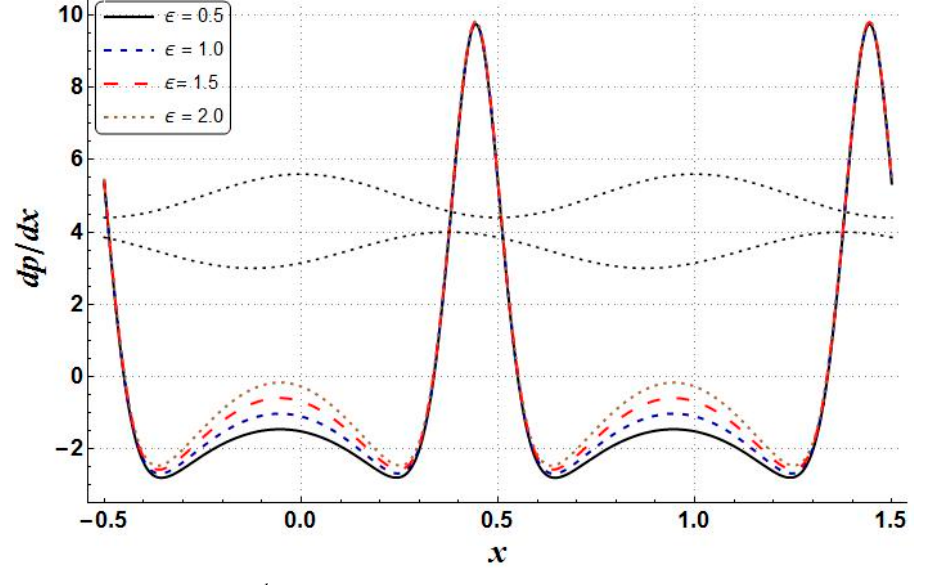
through changing values of ∈ , where γ = π dx